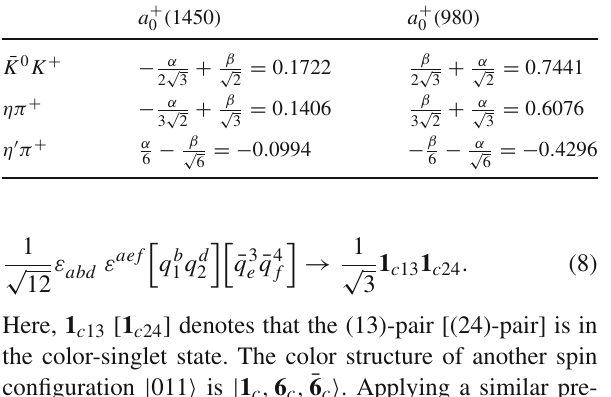
Table 1 The relative strengths of the couplings of a + to the channels ¯ K 0 K + , ηπ + , η (cid:8) π + , are presented here with common overallfactorbeingomitted.Themixingparameters α,β giveninEq.(4) have been used in getting the numbers